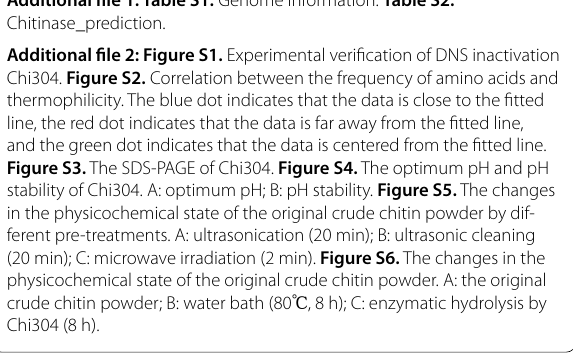
Additional file 2: Figure S1. Experimental verification of DNS inactivation Chi304. Figure S2. Correlation between the frequency of amino acids